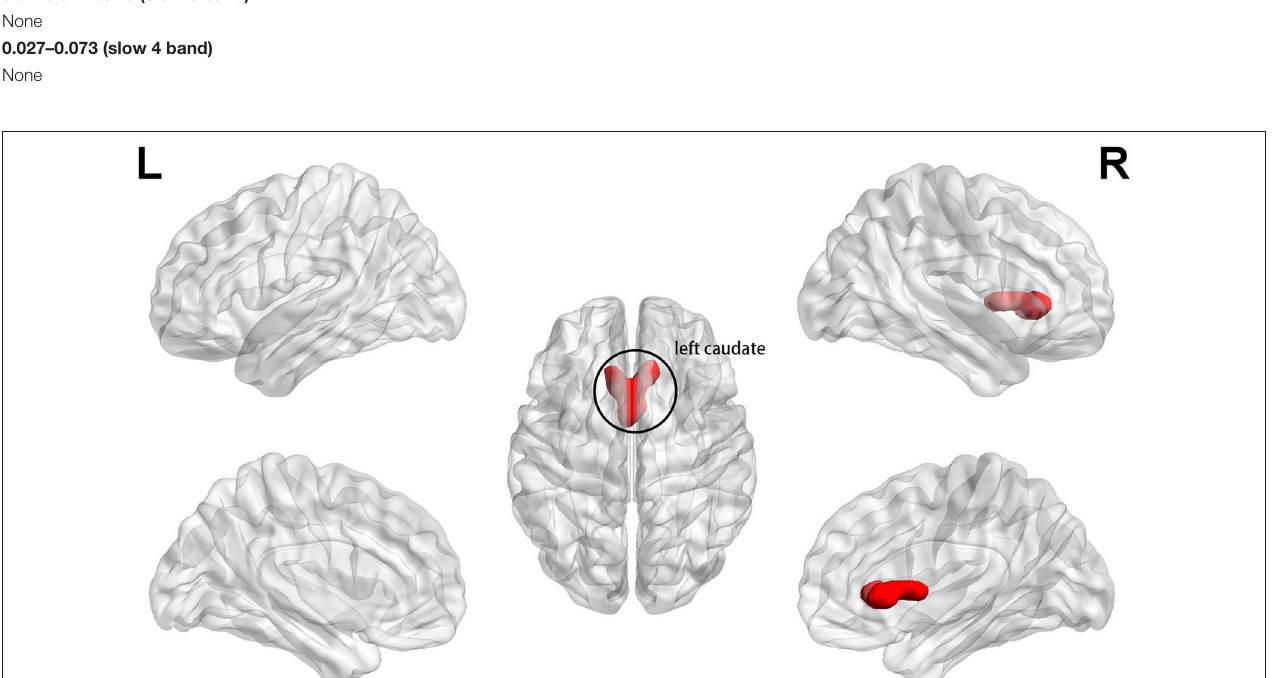
FIGURE 2 | At baseline, patients exhibited higher slow 5 fALFF in left caudate (cluster C) when compared with healthy controls ( p < 0.025, FWE corrected, CZ = 100).